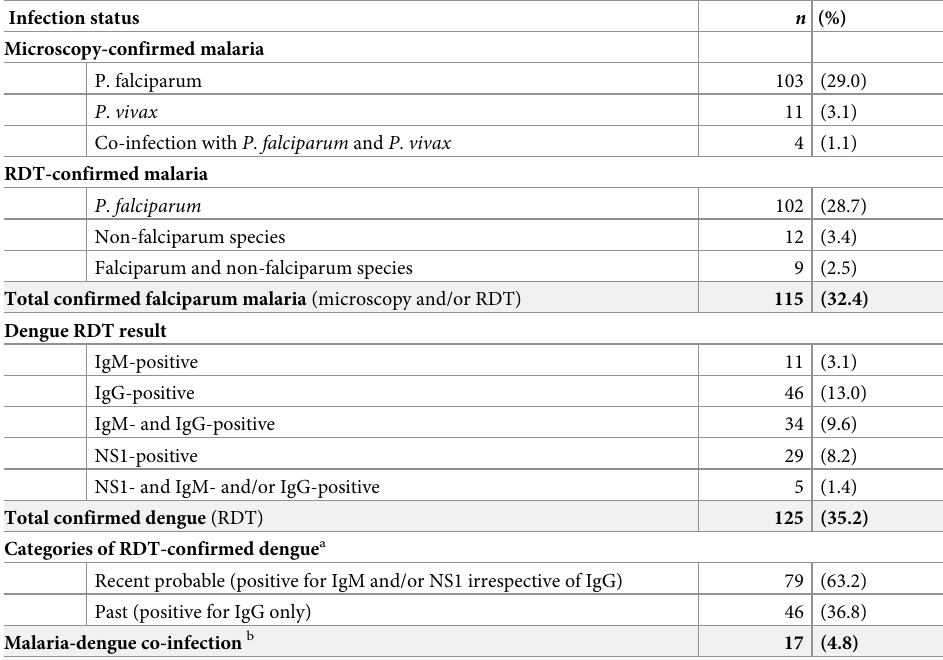
Table 2. Positivity of malaria and dengue among febrile patients attending the outpatient departments in hospi- tals of Hodeidah city, Yemen (2018–2019) �